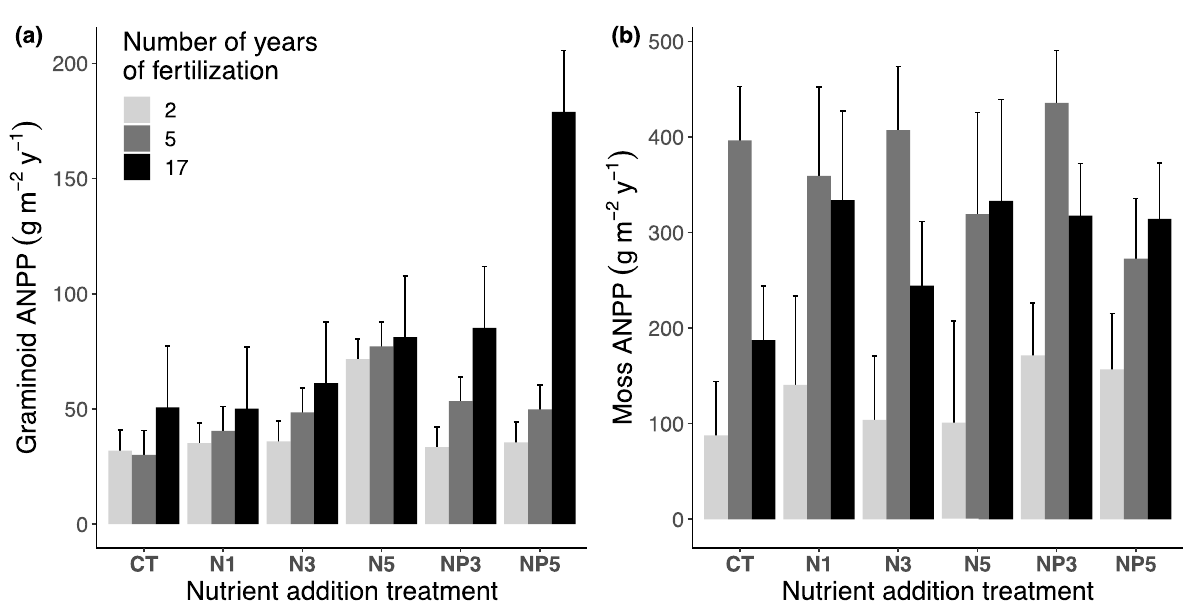
Figure 2. Aboveground net primary productivity (ANPP) of ( a ) graminoids separated by graminoid family and ( b ) mosses according to fertilization treatments after 17 years of experimentation in the tundra wetlands of Bylot Island, Nunavut. Least square means + SE are presented. See Methods for definition of treatments.